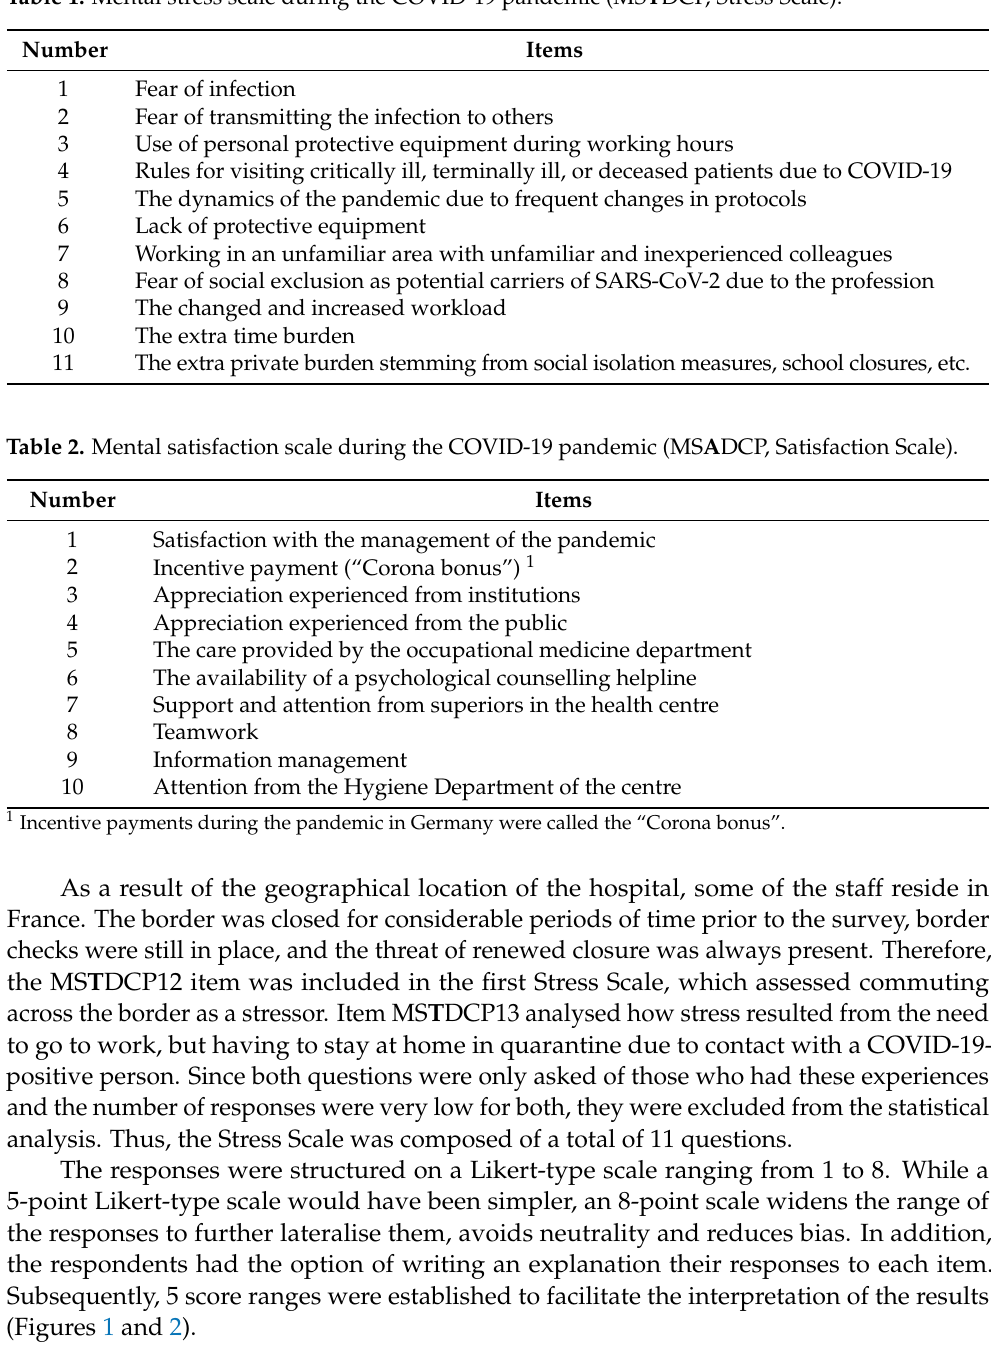
Table 1. Mental stress scale during the COVID-19 pandemic (MS T DCP, Stress Scale).